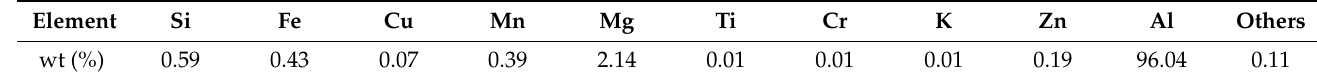
Table 2. Chemical composition of aluminum alloy. Adapted from [2].